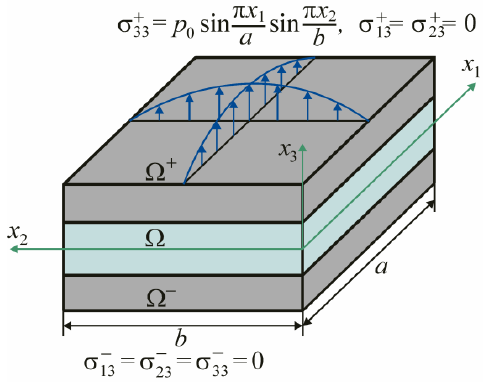
Figure 4: Three-layer rectangular plate subjected to transverse sinusoidal loading.